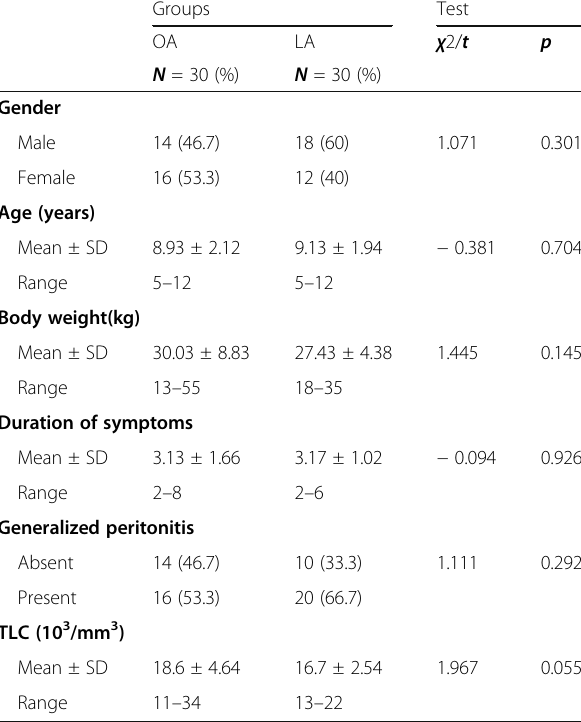
Table 2 Intraoperative details and postoperative course